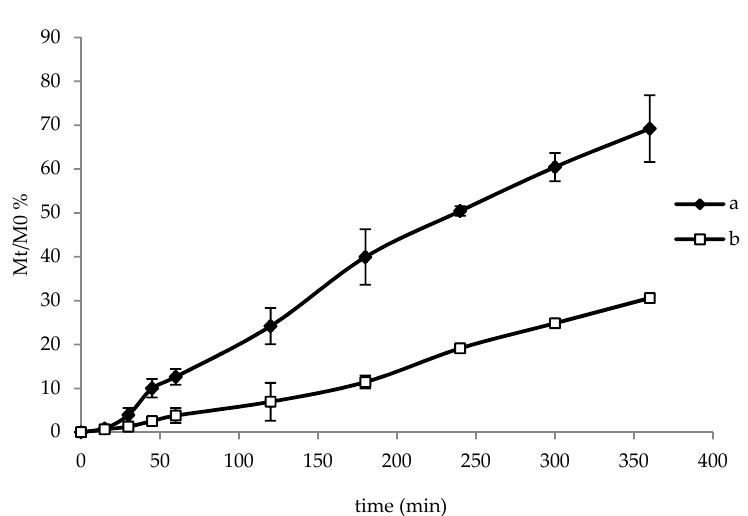
Figure 5. Lactobacilli release in phosphate buffer at pH 6.8 over time: ( a ) loaded face towards the medium; ( b ) loaded face towards the glass slide. Data are expressed as mean of three measurements ± standard deviation.